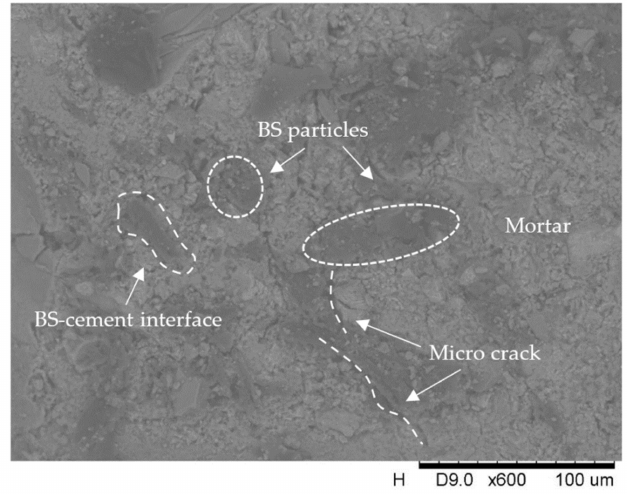
Figure 9. SEM analysis of alkali-treated